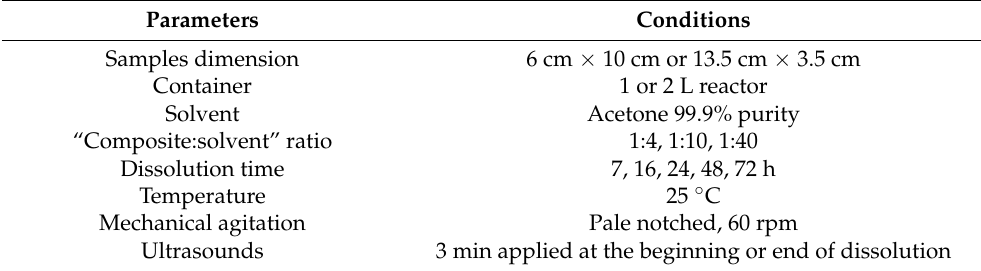
Table 1. Conditions of